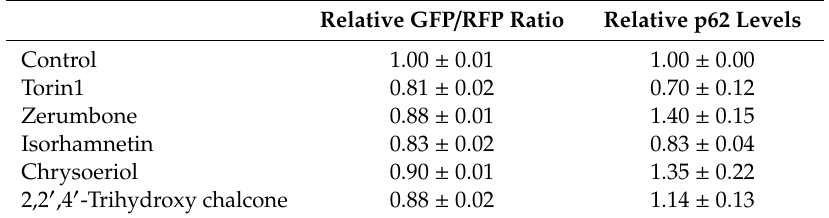
Table 1. E ff ects of phytochemicals on autophagy flux and p62 expression in Caco-2